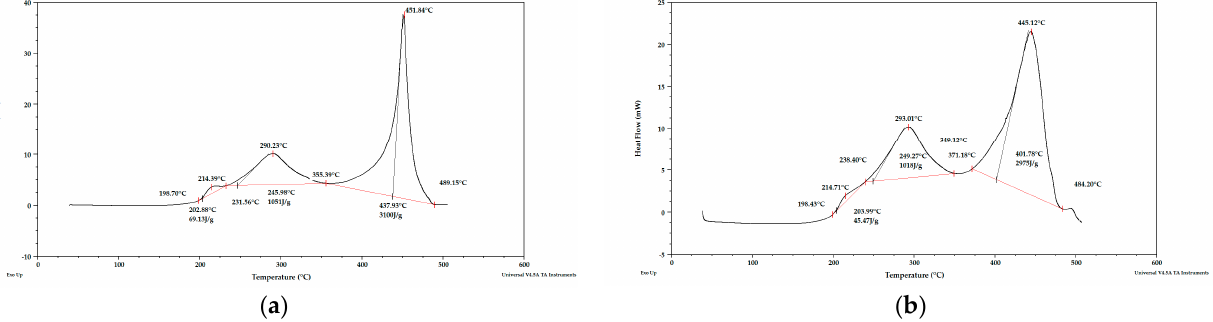
Figure 10. PDSC curves for apple pomace dried at 60 °C ( a ) sample 1, ( b ) sample 2. Analysis under oxygen atmosphere.